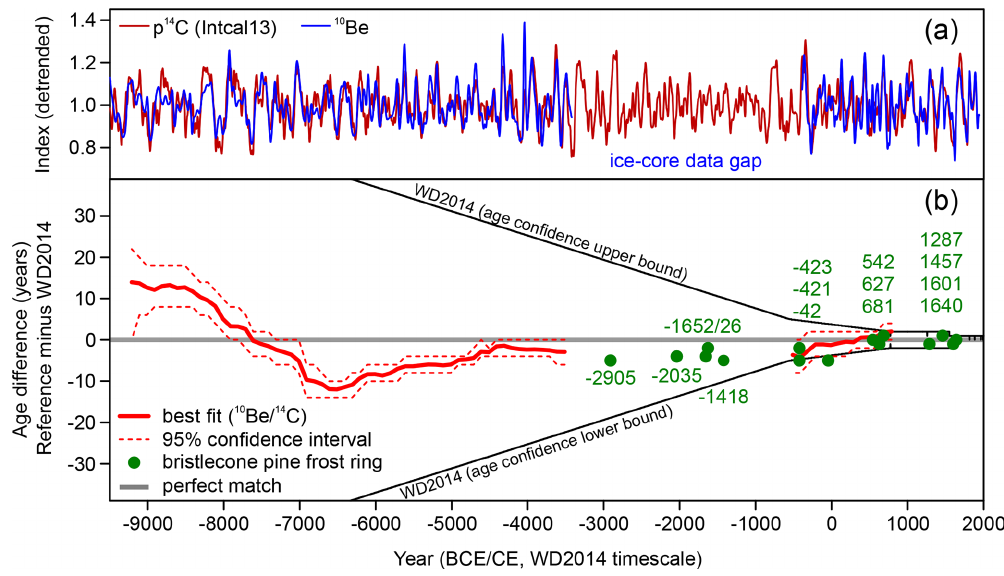
Figure 11. Estimated age uncertainty, and a comparison of WD2014 and independent chronologies based on dendrochronology: panel (a) shows the filtered WD 10 Be (blue) and 14 C (red) tree-ring data on their respective timescales, and panel (b) shows the most likely time shift (red line, 2kyr sliding window) for the highly significant correlations along with the 2 σ uncertainty range (see Sigl et al., 2016, for details). Green circles mark the age difference between major reconstructed eruptions (VSSI > 10Tg) and cooling anomalies (i.e., co-occurrence of frost-ring and ring-width minima within ± 1 year) in a 5kyr bristlecone pine chronology from the southwestern USA. A complete list of the selected event years is given in Table 4 and in the Supplement (Table S2) and was extracted from the compilation by Salzer and Hughes